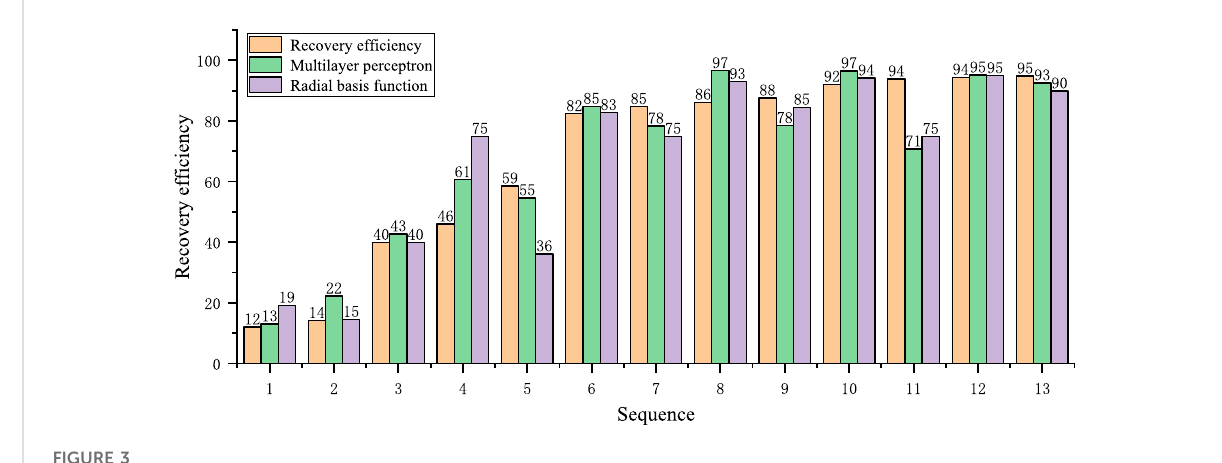
FIGURE 3 Prediction results of gas reservoir recovery prediction neural network model.